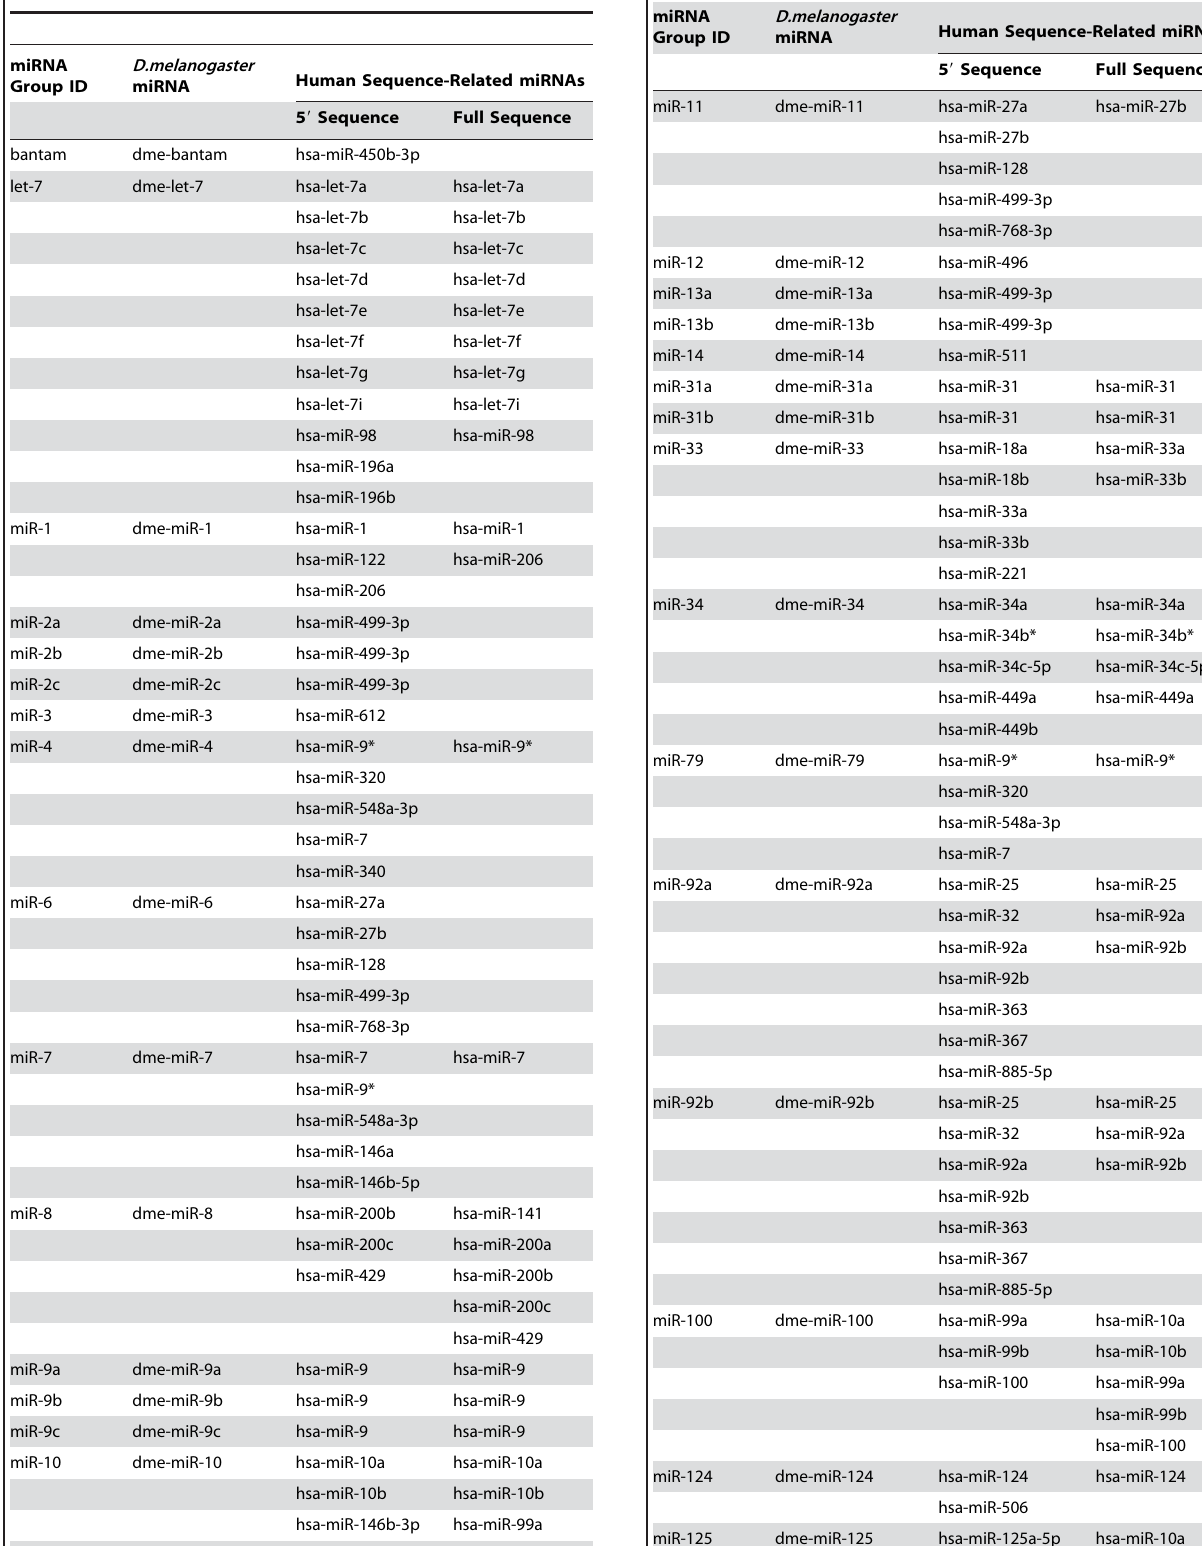
Table 5. Analysis of 5 9 and $ 70% similarity groups identifies 83 D. melanogaster -human miRNA families including 83 fly miRNAs and 121 human